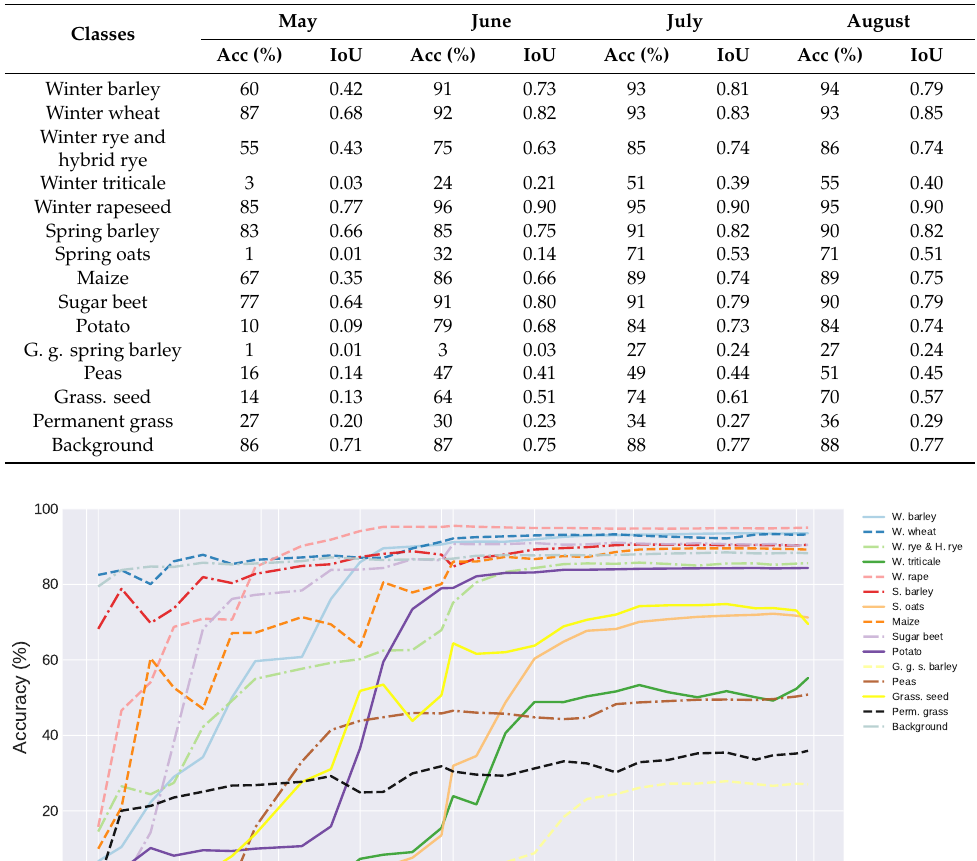
Table 2. The performance when analyzing multi-temporal images. In the table Acc and IoU are pixel-based accuracy and Intersection over Union, respectively.